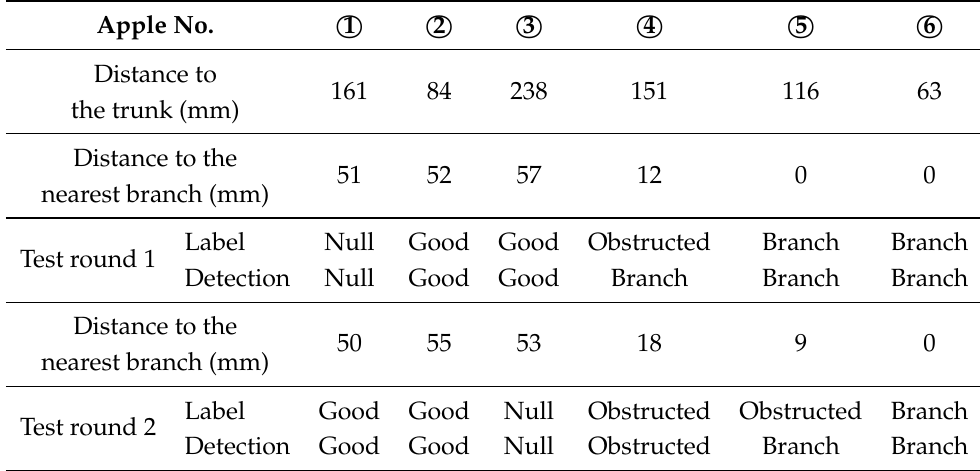
Table 3. Experiment result of grasping status detection on the robotic harvesting system. Apple